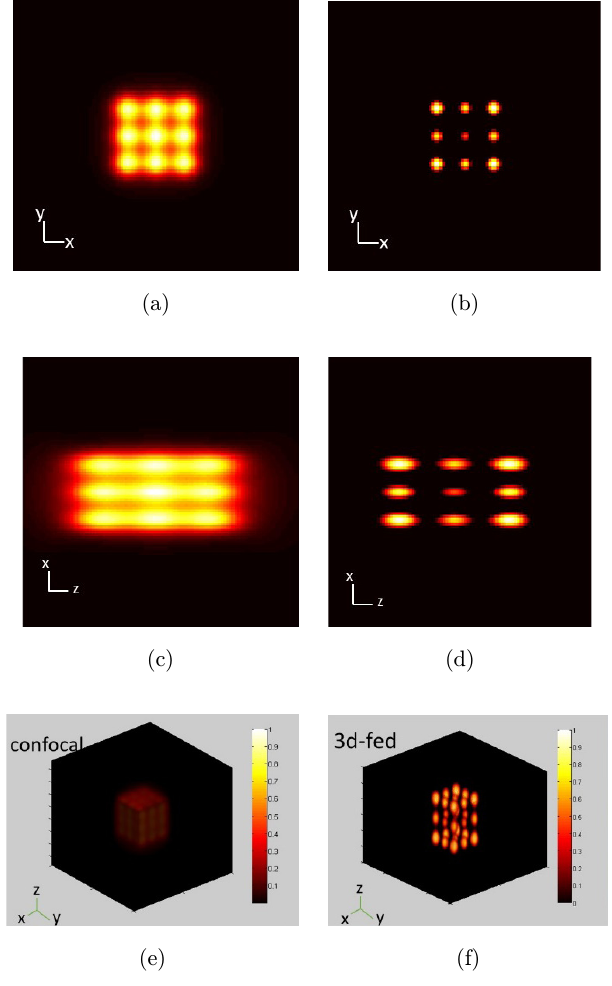
Fig. 2. Simulation results of a 3 (cid:2) 3 (cid:2) 3 point array sample. Side length of the scope is 4 (cid:5) . (a) and (c): Lateral and axial images of confocal microscope. (b) and (d): Lateral and axial images of 3D-FED microscope. (e) and (f): 3D display of con- focal and 3D-FED microscope.